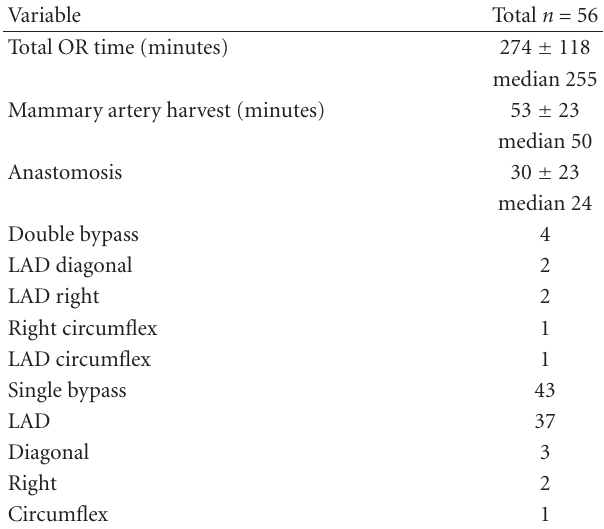
Table 3: Operative variable.